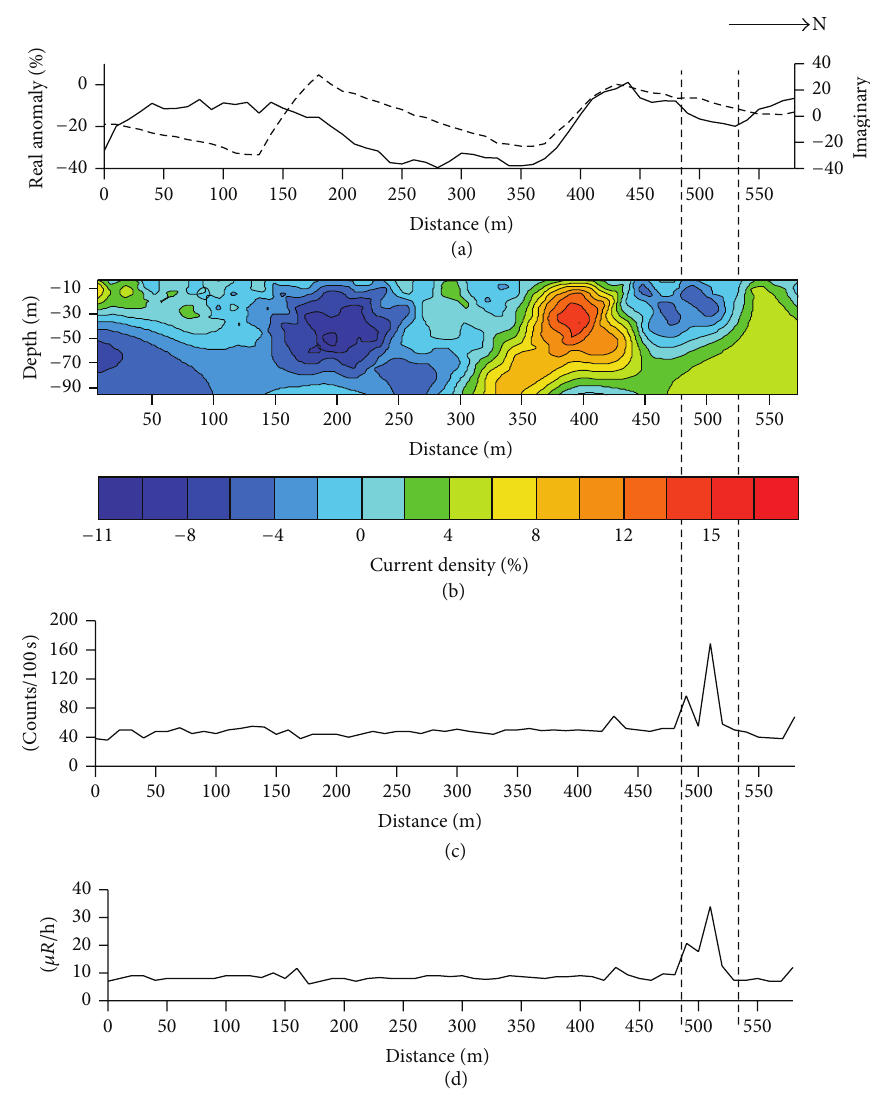
Figure 6: Profile P1500: (a) VLF anomaly (real by solid line and imaginary by dashed line), (b) pseudo current density cross-section along profile P1100, and (c) surface radiation and (d) surface gamma